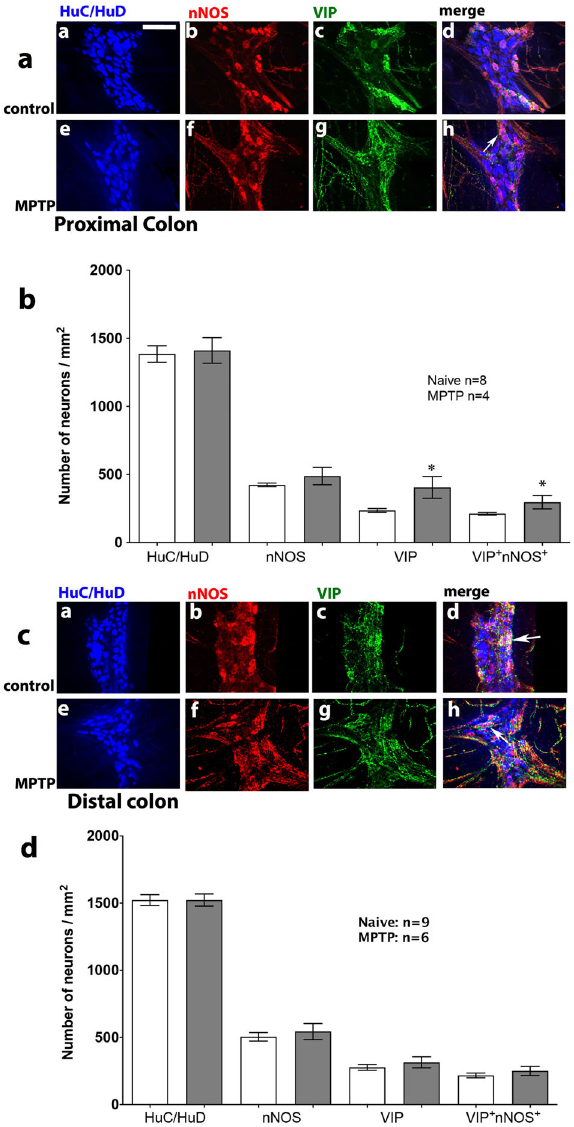
Fig. 6 Effect of MPTP treatment on the number of HuC/D-, nNOS- and VIP-ir, in the proximal and distal colon of naïve control and MPTP-treated common marmosets. Inset panels ( a , e ) show HuC/D- ir; ( b , f ) show nNOS-ir and ( c , g ) show VIP-ir in the proximal ( a ) and distal ( c ) colon of naïve control and MPTP-treated common marmosets. Panels ( d , h ) show triple immuno fl uorescence for HuC/ HuD (blue), nNOS (red) and VIP (green) in the myenteric plexus from proximal (main panel a ) and distal (main panel c ) colon of na ϊ ve and MPTP-treated animals. Quantitative analysis of nNOS- and VIP-ir neurons in MPTP-treated marmosets compared to na ϊ ve controls in the proximal and distal colon is shown in the main panels ( b ) and ( d ), respectively. The number of immunoreactive neurons are expressed as mean ± SEM. * P < 0.05 compared to naïve control (Students t -test). White arrows indicate co-localisation of nNOS and VIP. The scale bar in panel ( aa ) indicates 100 µm.